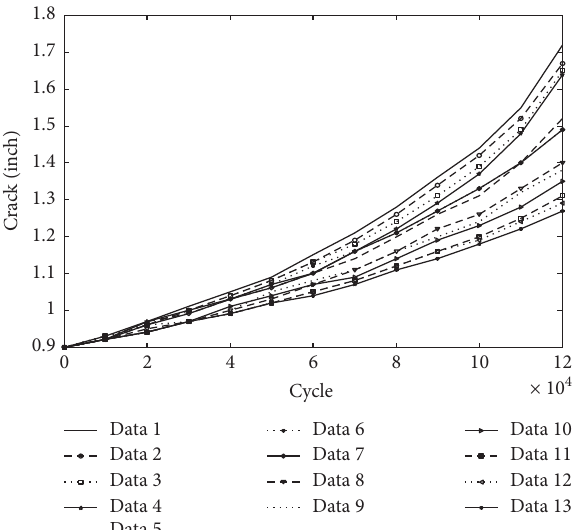
Figure 3: Fatigue crack growth paths of samples.